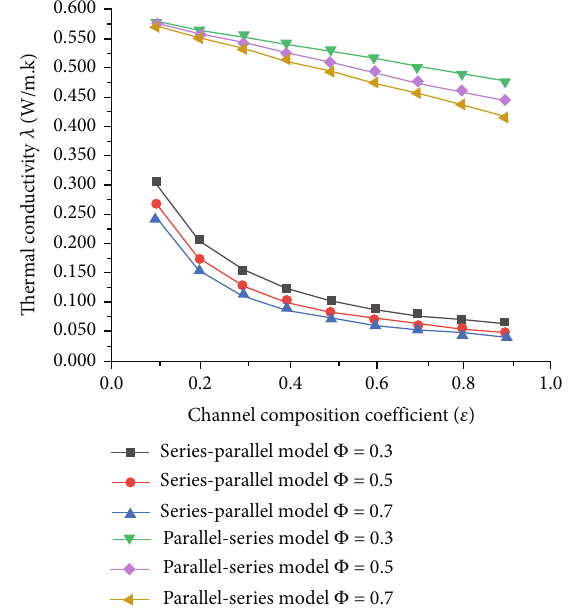
Figure 19: Relationship between thermal conductivity λ and channel composition coe ffi cient ε of integrated REV model with di ff erent porosity φ